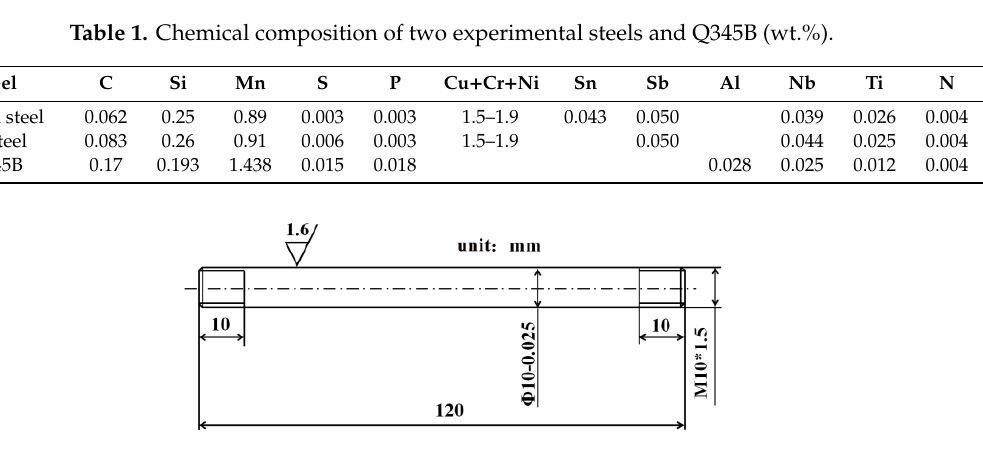
Figure 1. Shape of specimens for hot tensile tests. Table 1. Chemical composition of two experimental steels and Q345B (wt.%).